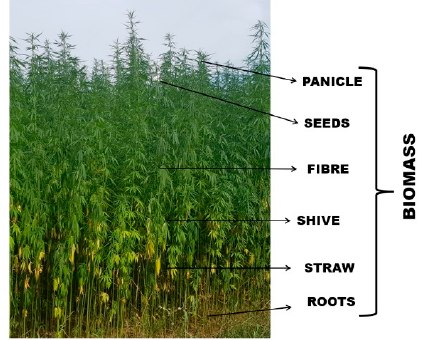
Figure 1. The hemp plant, variety Bialobrzeskie.